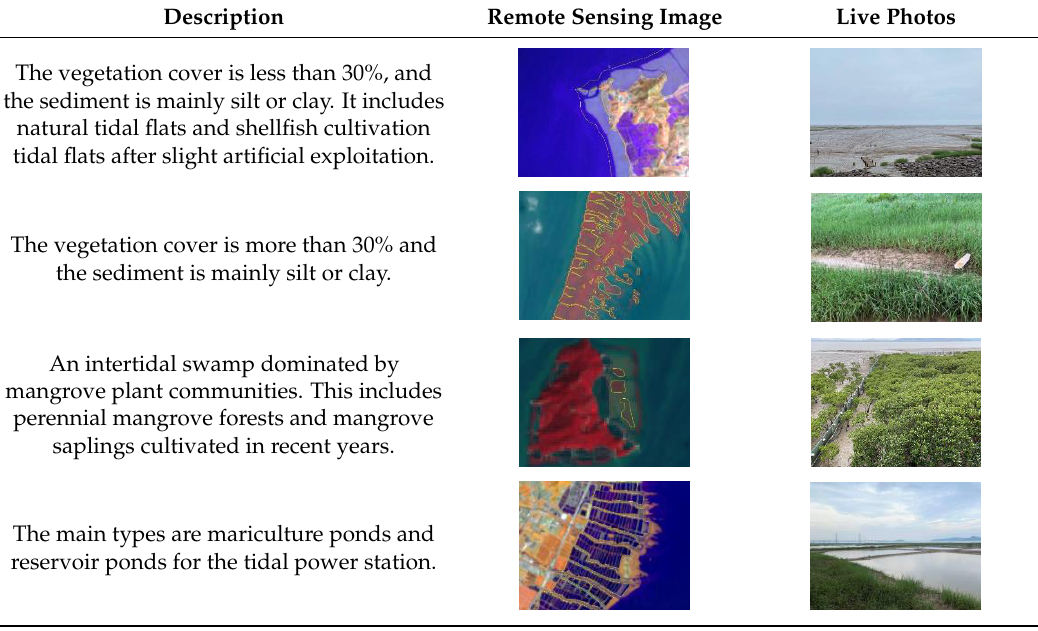
Table 2. Tidal wetland classification system and interpretation symbol.